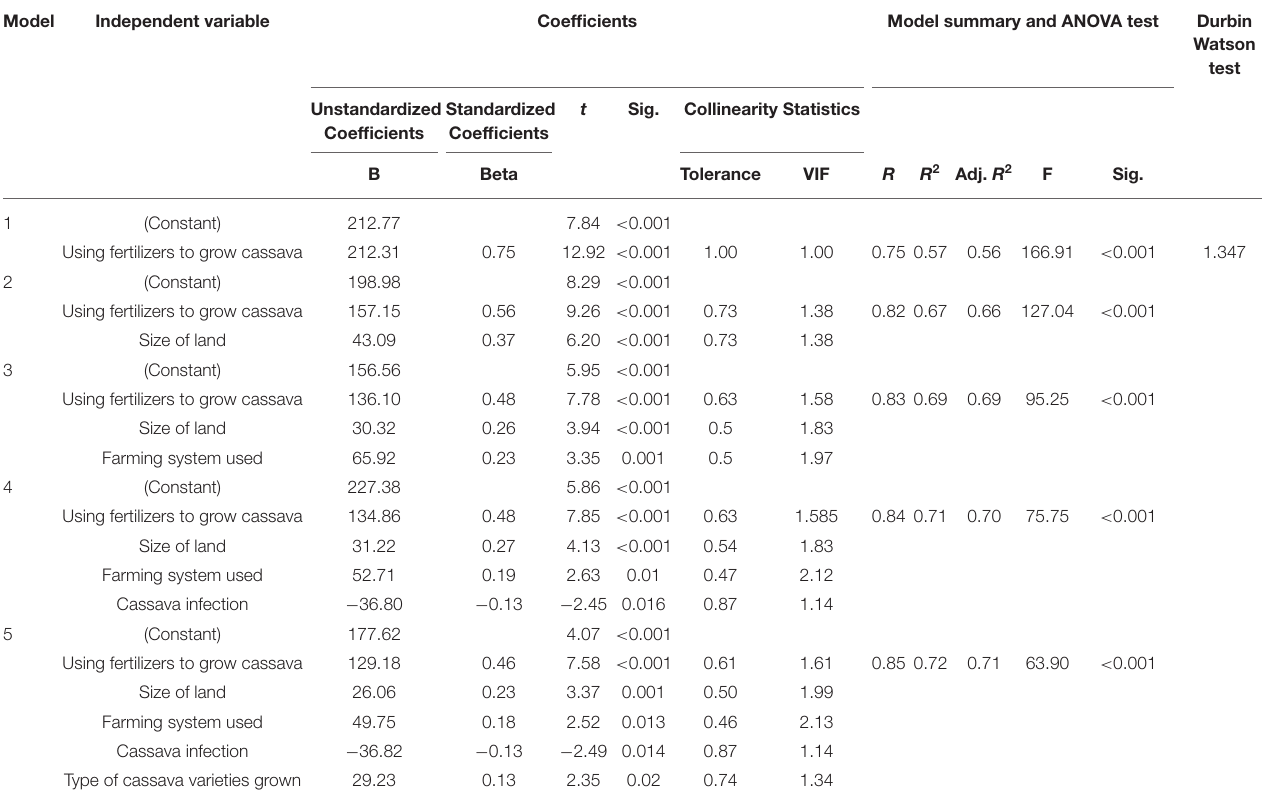
TABLE 6 | Multiple linear regression for cassava